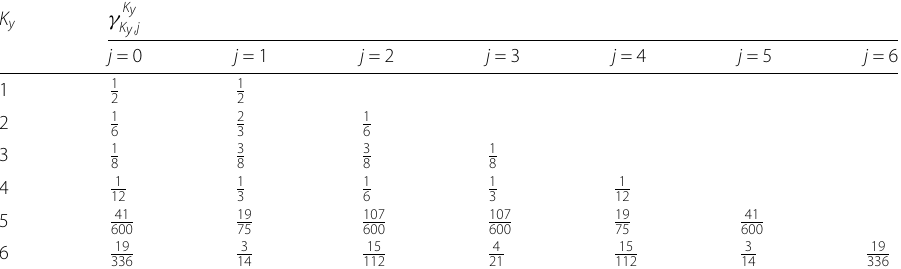
Table 1 The coefficients { γ